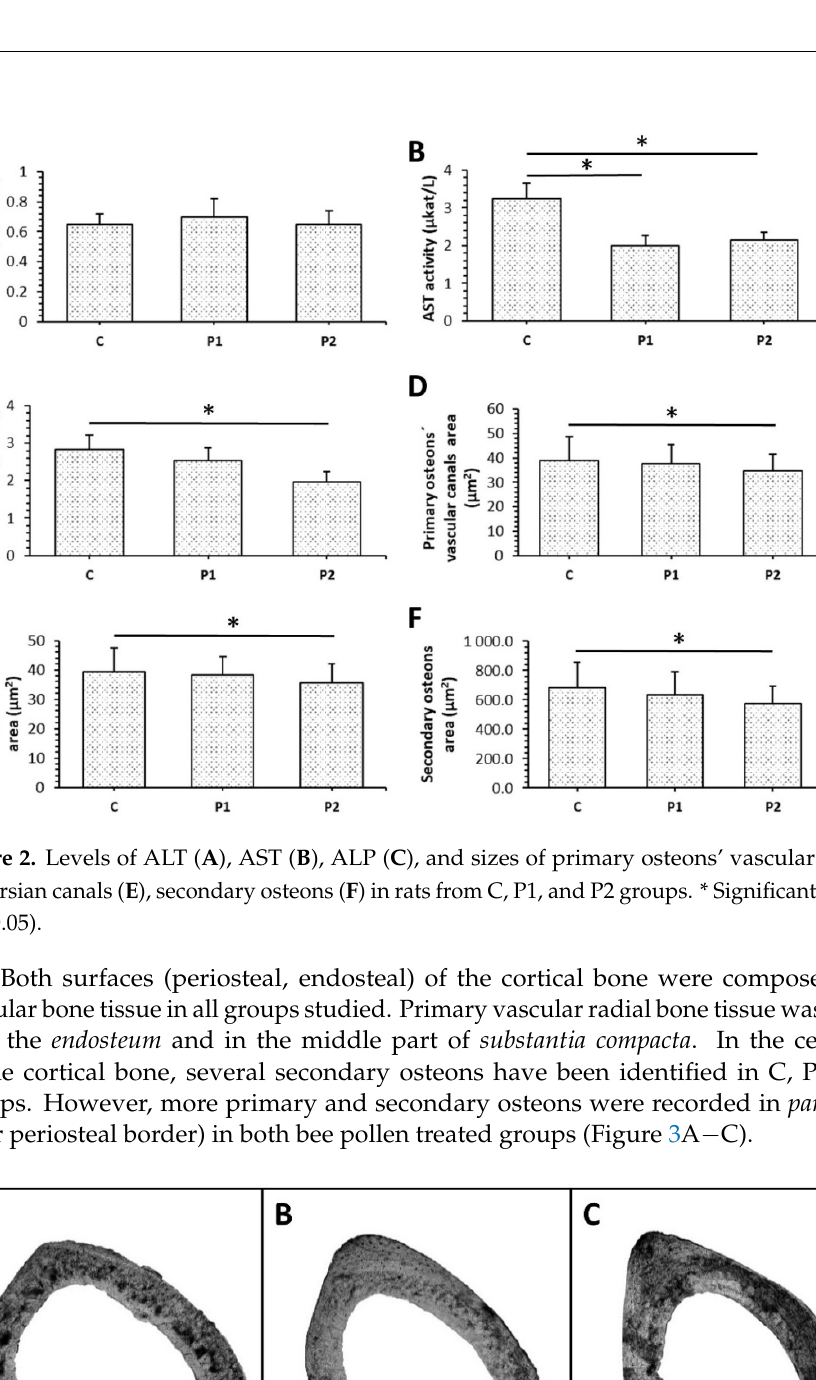
Figure 3. Cortical bone microscopic structure of rats from C ( A ), P1 ( B ) and P2 ( C ) groups.